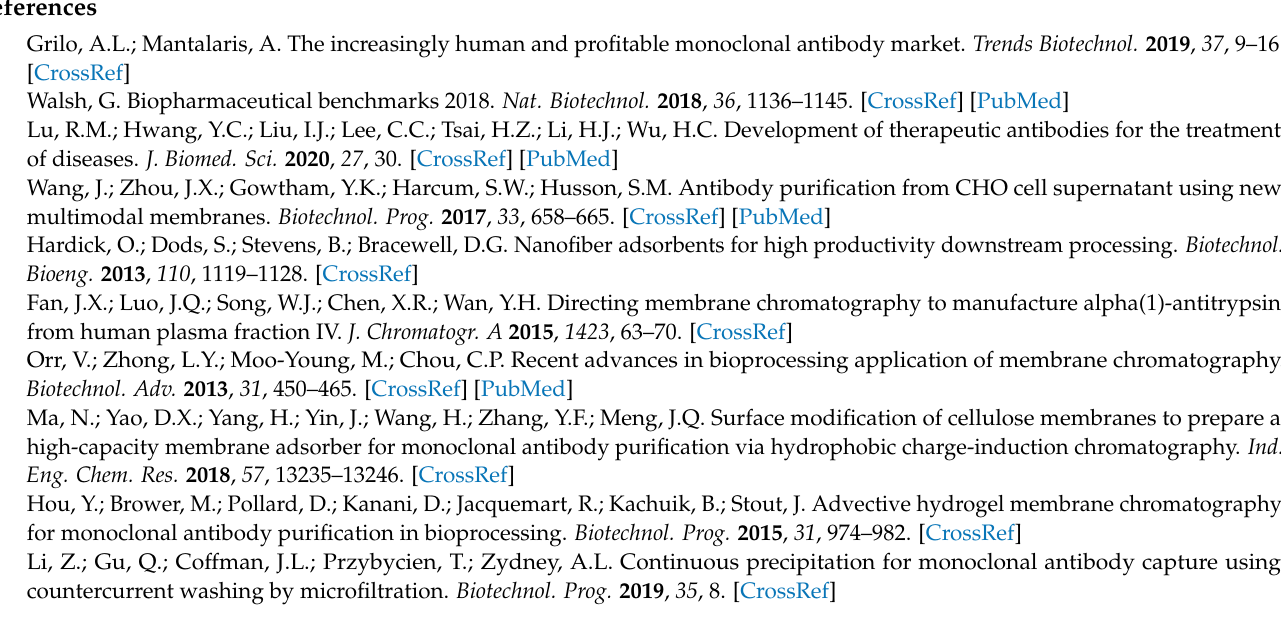
Superficial flow velocity versus pressure drop; Figure S3: Chromatogram of five consecutive IgG bind and elute cycles at different RTs from 0.1 to 5.0 min; Figure S4: Equilibrium adsorption isotherm of IgG onto CEX-IDA membranes; Figure S5: Chromatogram of DBC 10% measurement at 0.1 min RT; Figure S6: Chromatogram of DBC 10% measurement at 1.0 min residence time; Figure S7: Protein G column analysis of protein samples collected from the first cycle of mAb capture from cell culture fluid and S8: Protein G column analysis of protein samples collected from the second to fifth cycles for mAb capturing. Reference [56] is cited in Supplementary